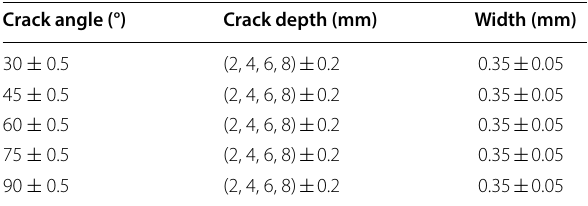
Table 1 Crack parameters of different angles and depths for different data